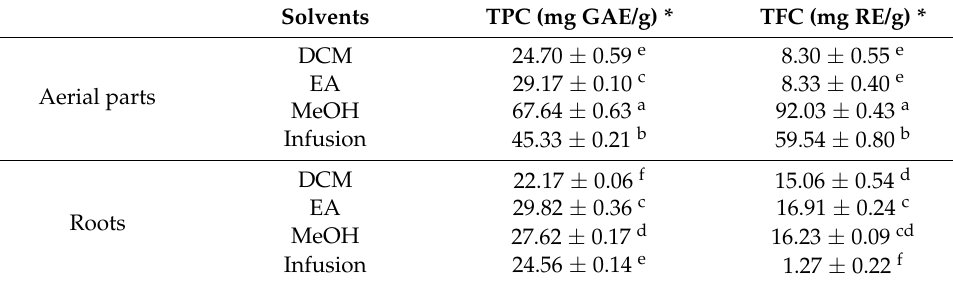
Table 1. Total phenolic and flavonoid contents of S. hedysaroides